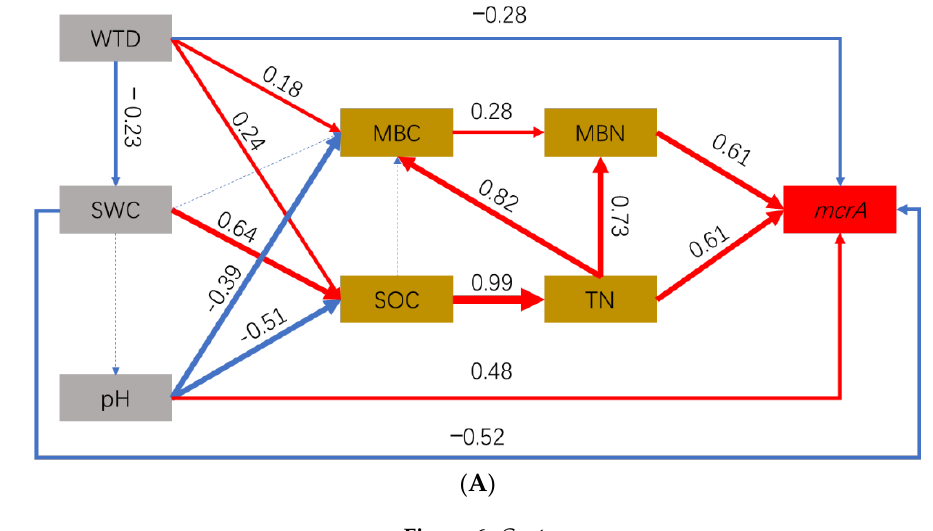
WTD: water table depth; SWC: soil water content; MBC: microbial biomass carbon; MBN: microbial biomass nitrogen; SOC: soil organic carbon; TC: total carbon; TN: total nitrogen. Symbols *, **, and *** indicate at the significance levels of 0.05, 0.01, and 0.001, respectively.